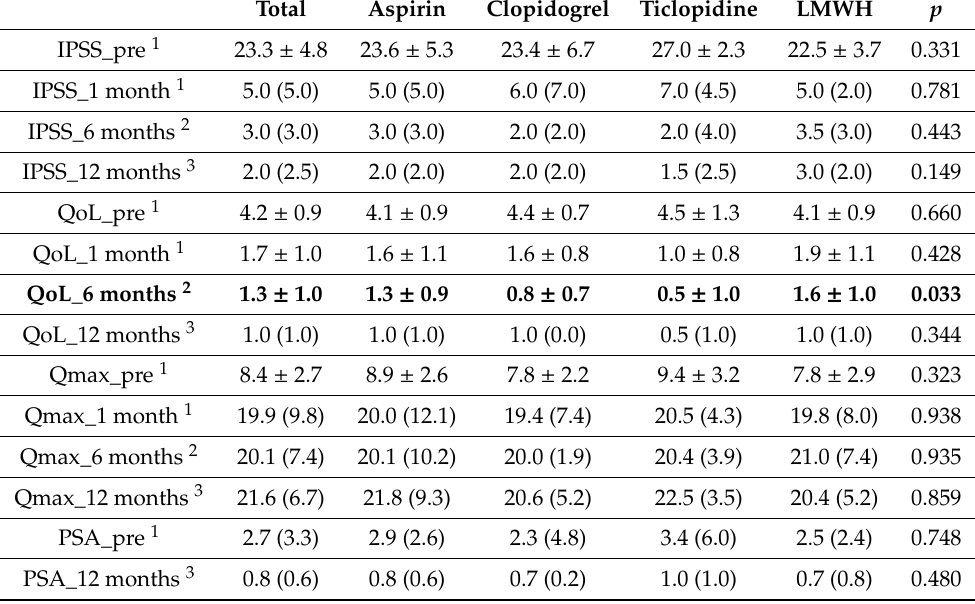
Table 5. Functional results at follow-up